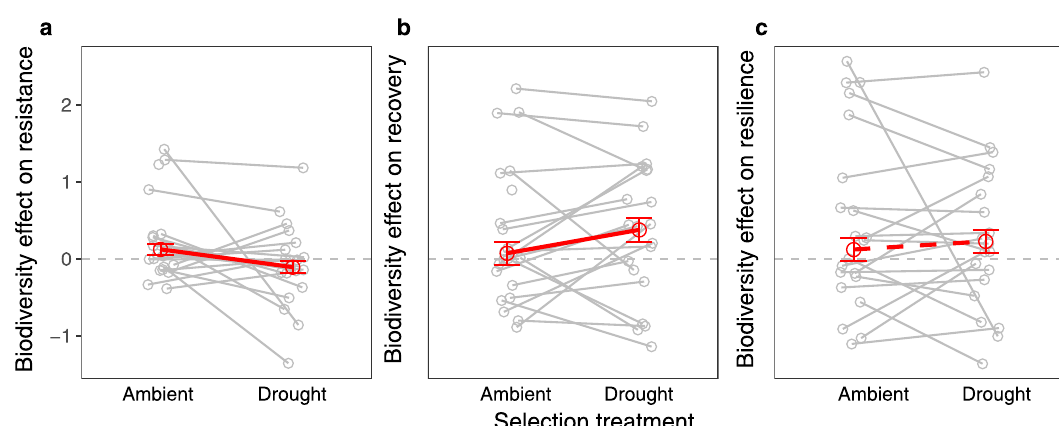
Fig. 3 Difference in biodiversity effects on biomass stability in response to the drought event in the glasshouse between selection treatments (ambient and drought-selected plants). The solid red lines indicate signi fi cant differences between the two selection treatments (see Supplementary Table 5). Biomass stability was calculated as resistance ( a ), recovery ( b ), and resilience ( c ). Biodiversity effects on stability were calculated as the differences in stability indices between mixtures and monocultures. Red points and error bars show the means ± standard error of 2-species mixtures of the corresponding selection treatment. Gray points represent means for species pairs (standard errors for species pairs not shown). Gray lines connect the same species pair between the two selection treatments. Source data are provided as a Source Data fi le. The numbers of mixtures per species pair (gray points) and per selection treatment (red points) are provided in the Source data fi